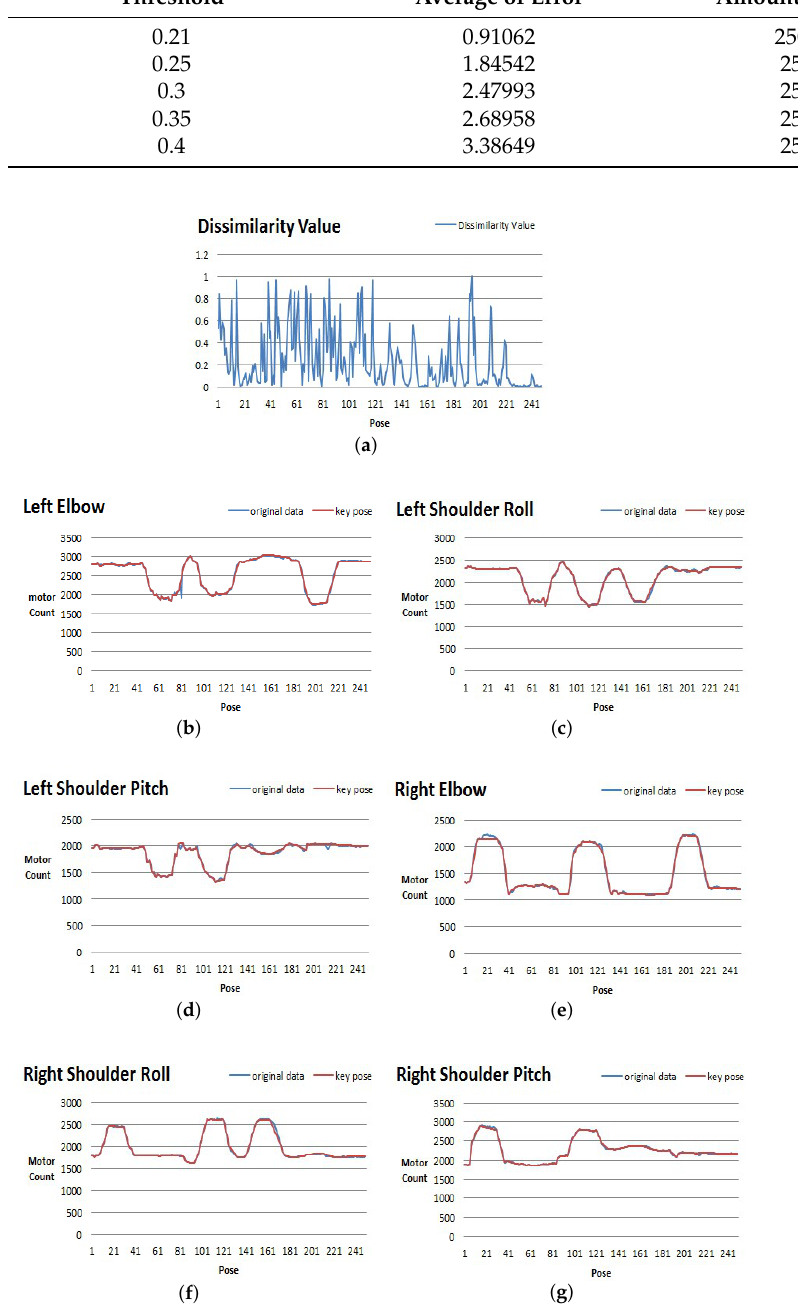
Figure 11. Results of revised key-pose algorithm based on dissimilarity versus original pose data. ( a ) Calculated dissimilarity value. ( b ) Motor counts data on Left Elbow. ( c ) Motor counts data on Left Shoulder Roll. ( d ) Motor counts data on Left Shoulder Pitch. ( e ) Motor counts data on Right Elbow. ( f ) Motor counts data on Right Shoulder Roll. ( g ) Motor counts data on Right Shoulder